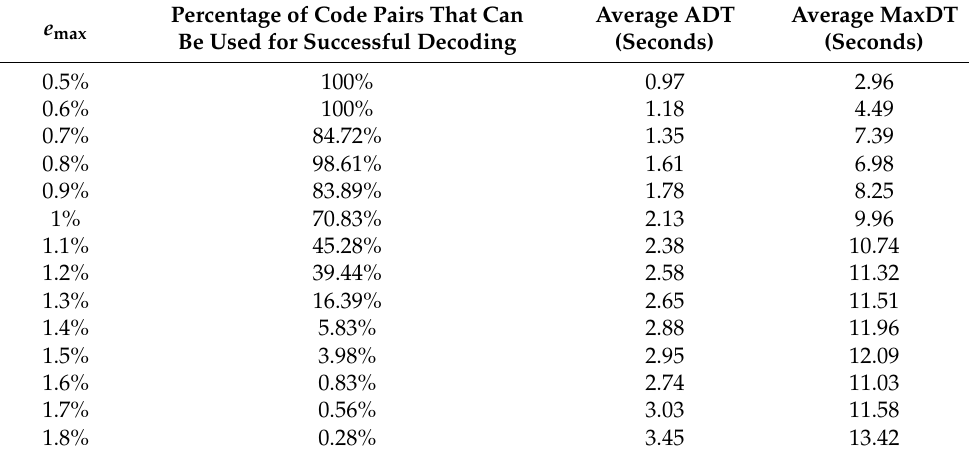
Table 1. Statistical analysis of the ADT and MaxDT (120 frames per second case).